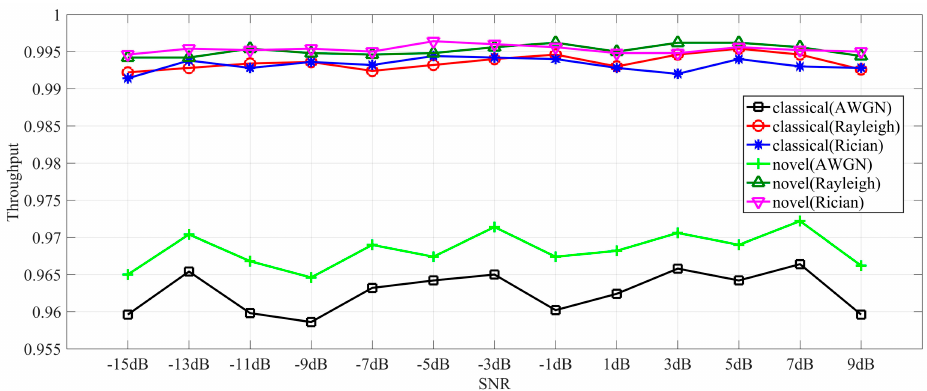
Figure 4. Throughput comparisons when the sensing performance is optimal.